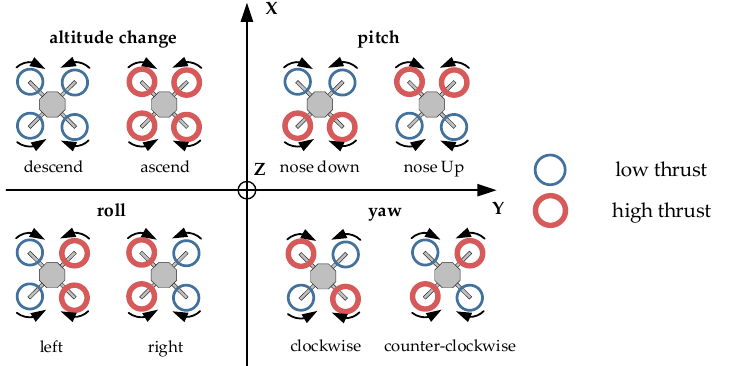
Figure 7. Basic principles of quadcopter maneuvering.